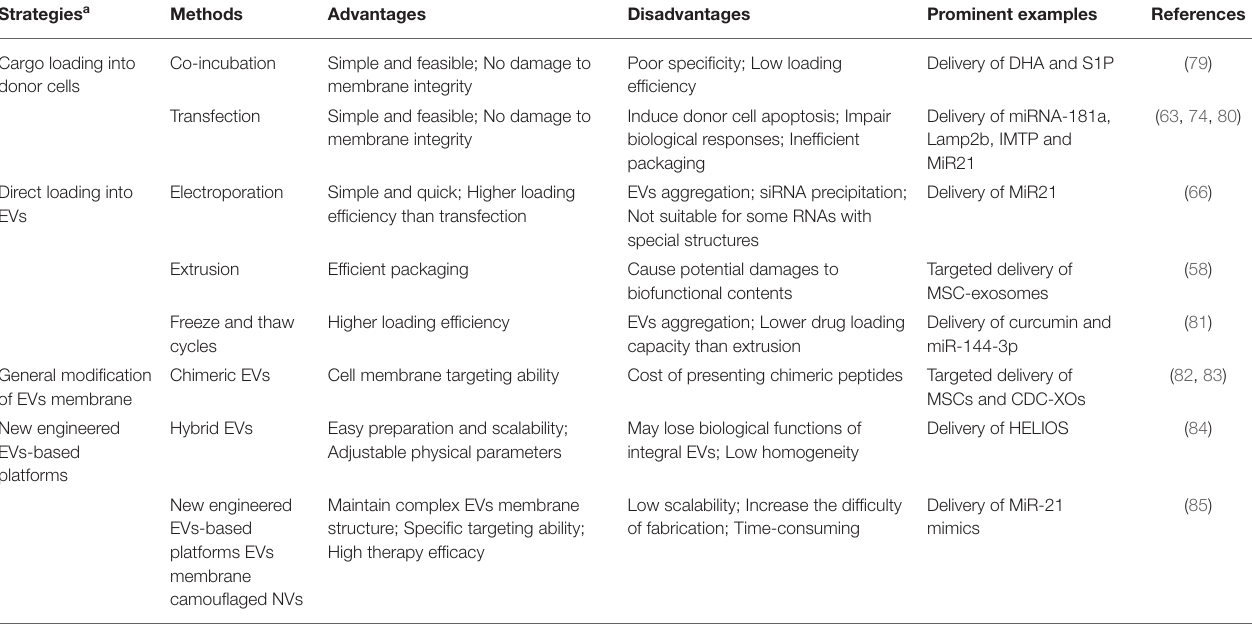
TABLE 2 | Strategies for cargo loading into